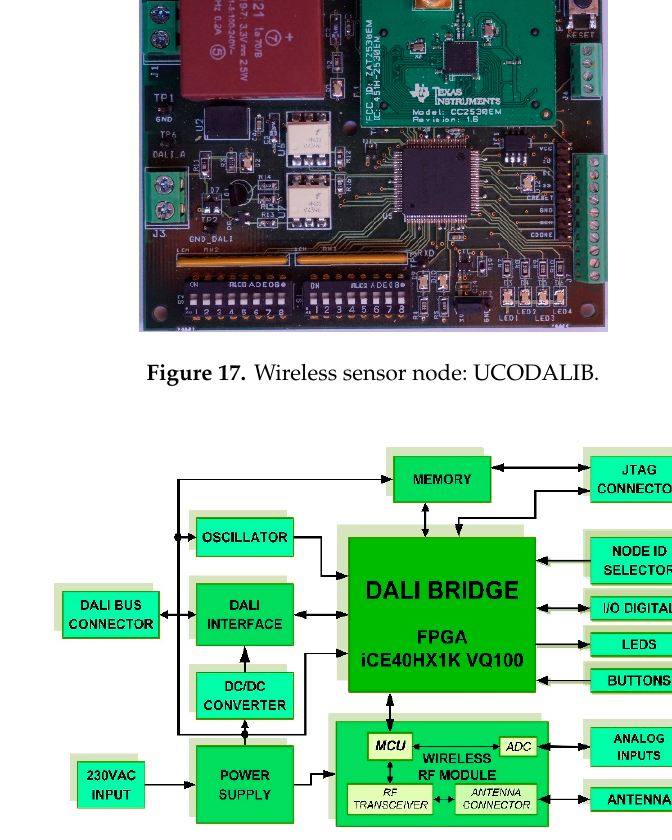
Figure 17. Wireless sensor node: UCODALIB.